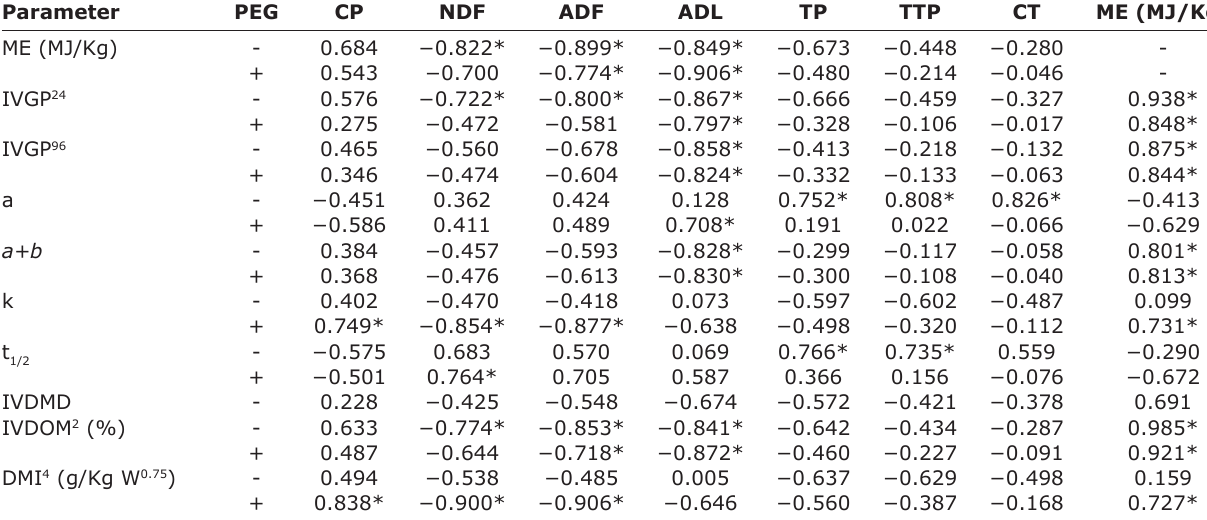
Table-5: Correlation coefficients (r) between in vitro fermentation parameters, IVDMD, IVDOM, and DMI with chemical composition and total phenolics and tannins. Parameter PEG